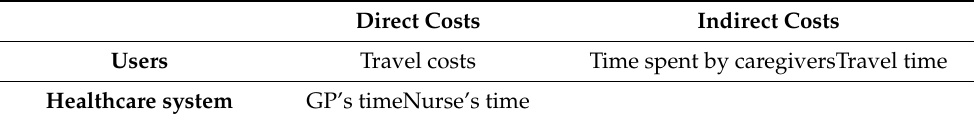
Table 2. Direct and indirect costs, for users and for the healthcare system.